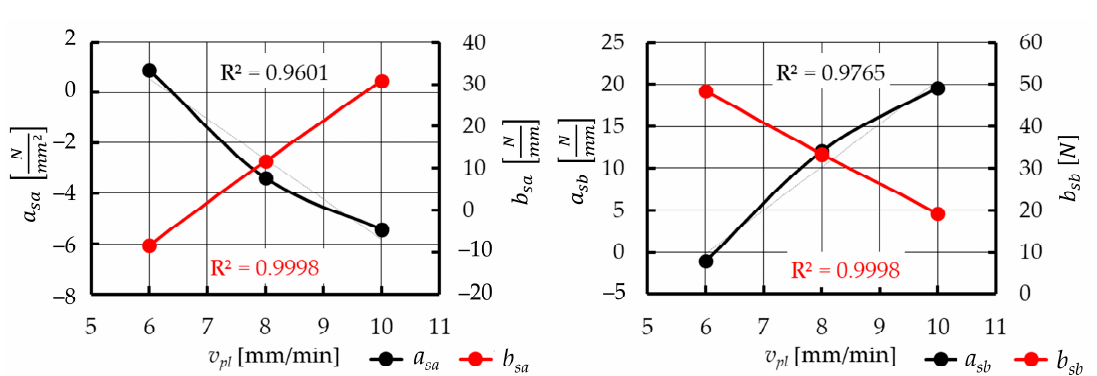
Figure 18. Exemplary correlation between the a sa , b sa , a sb , and b sb coefficients and the plasticization velocity v pl for the belt with 12 mm diameter, plasticized by the hot plate heated to temperature T p = 285 °C.